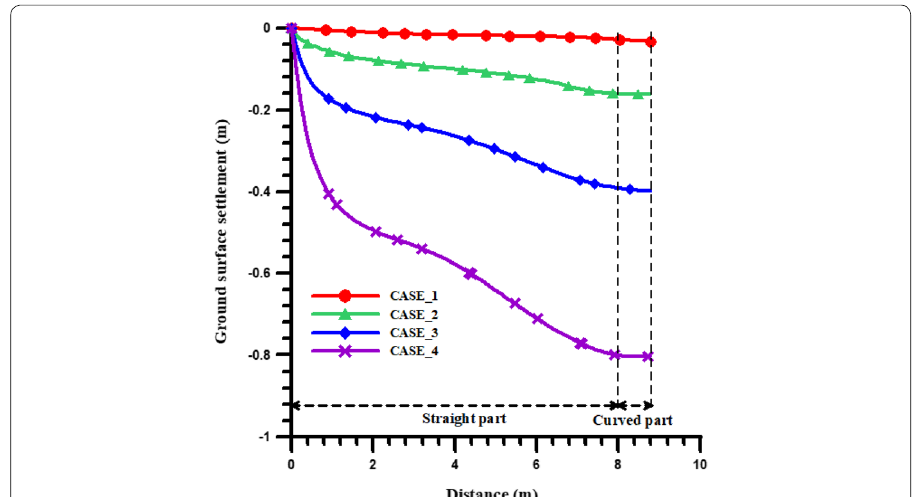
Fig. 21 Comparison of straight and curved parts for ground surface settlement